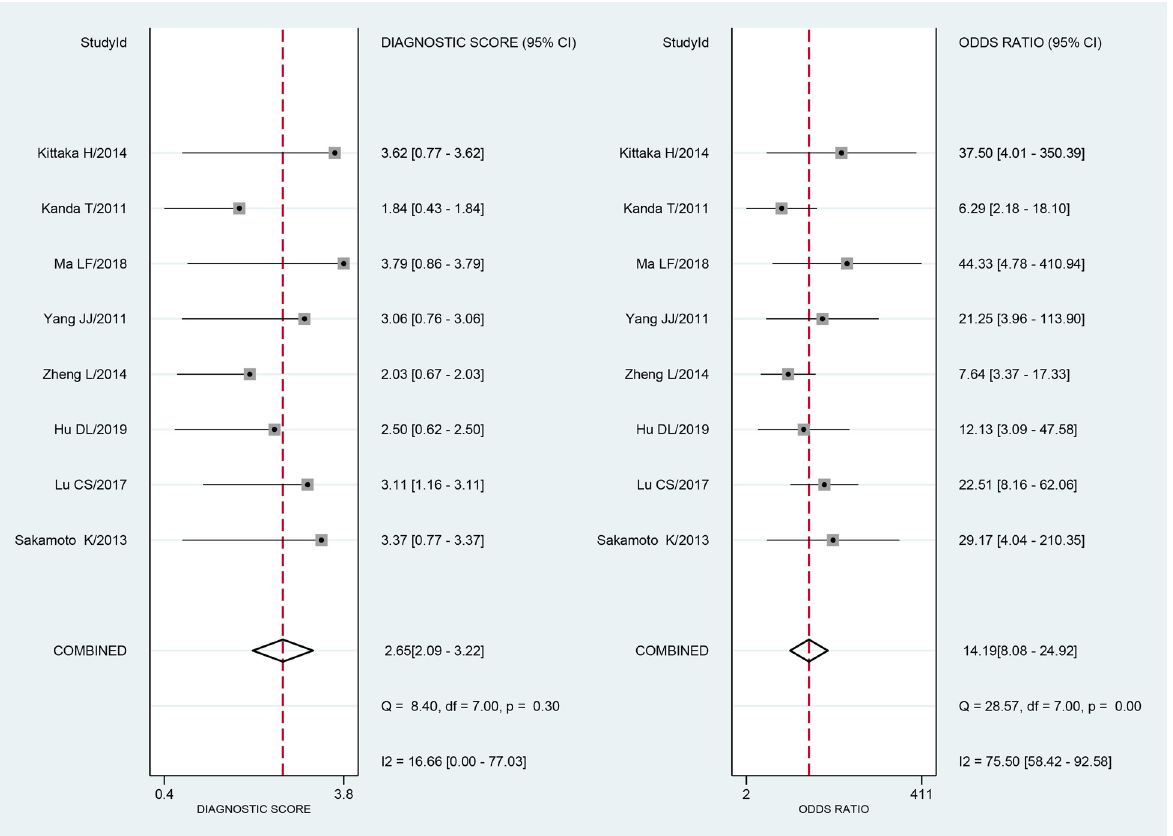
Figure 4: The forest plot of the DOR for serum I - FABP in diagnosis of strangulated intestinal obstruction.